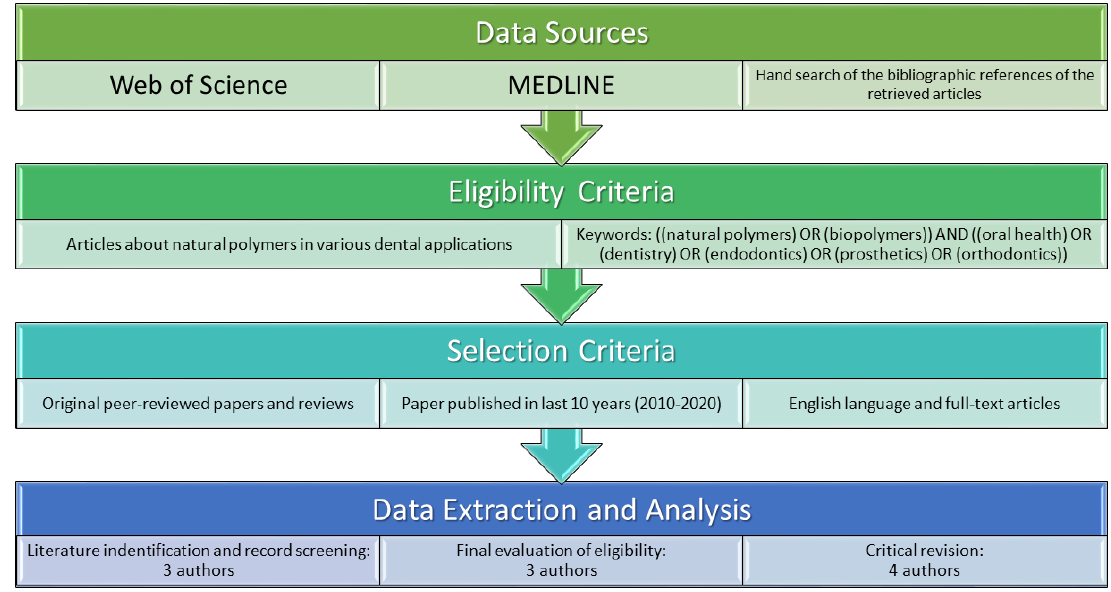
Figure 1 . Flow diagram presenting the search strategy. Figure 1. Flow diagram presenting the search